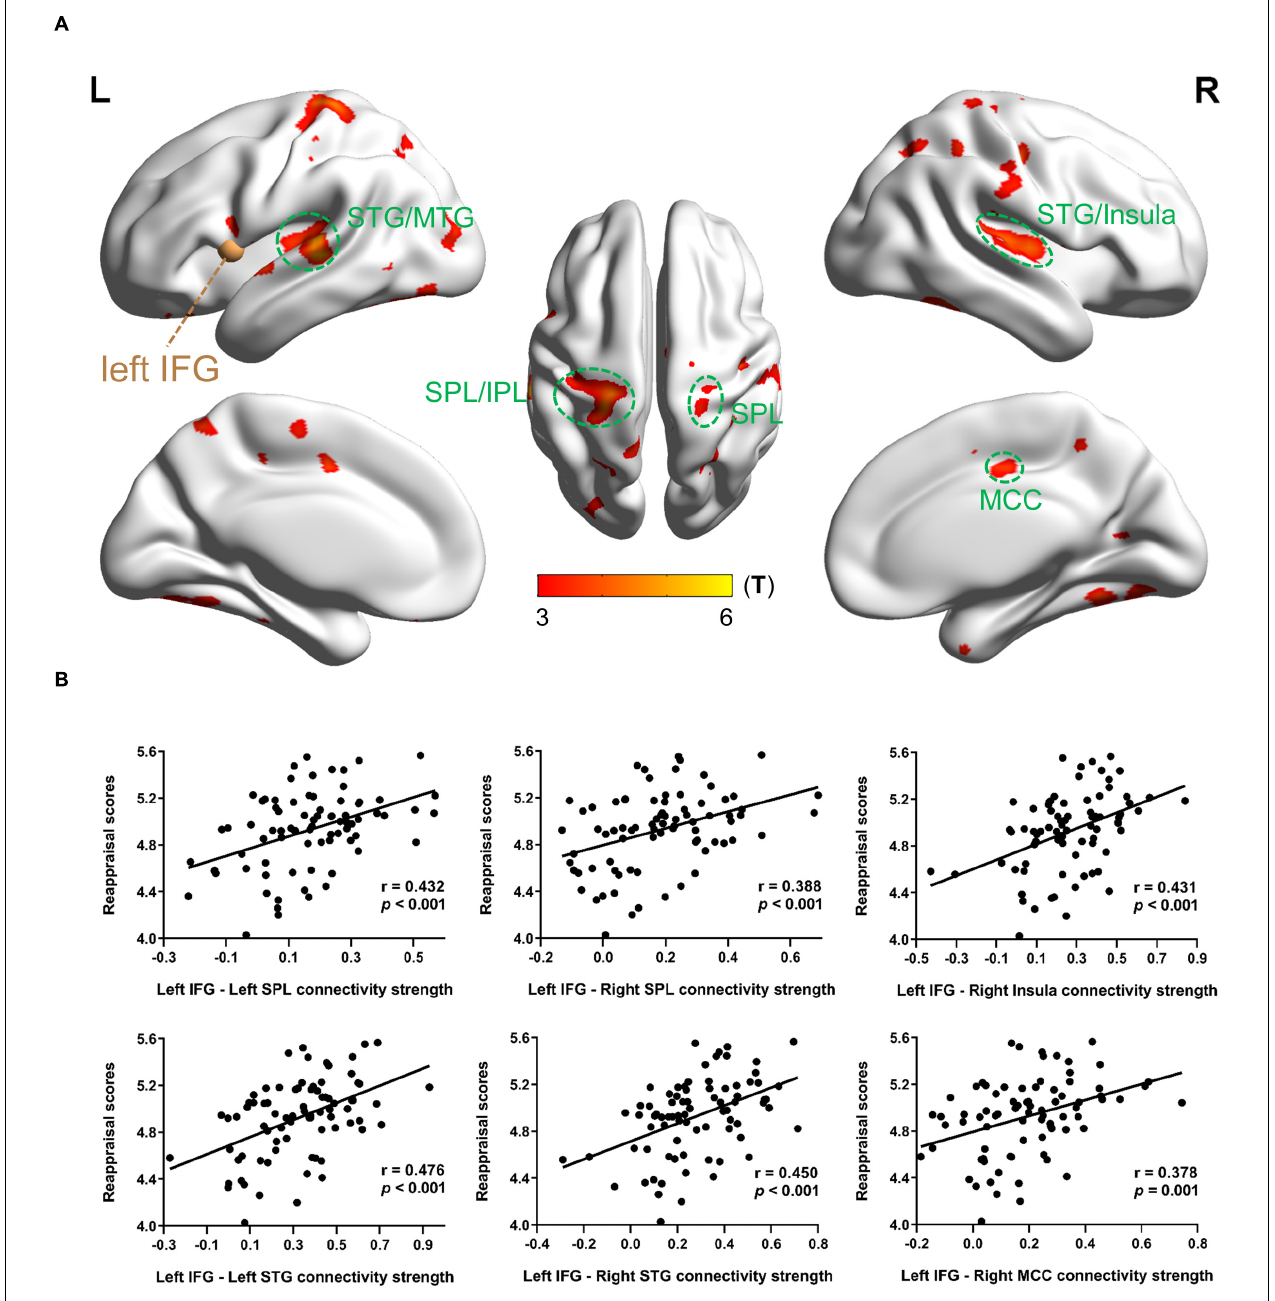
FIGURE 2 | Results of the left IFG-based rsFC related with dispositional use of reappraisal in MRG. (A) Brain regions whose rsFC correlated with reappraisal scores. The brown sphere represented the seed region, and the green circles were drawn to display the ROIs. (B) Partial regression scatter plots depicted the correlation between functional connectivity strength and reappraisal scores. Statistical threshold of false discovery rate P FDR < 0.05 was used for cluster